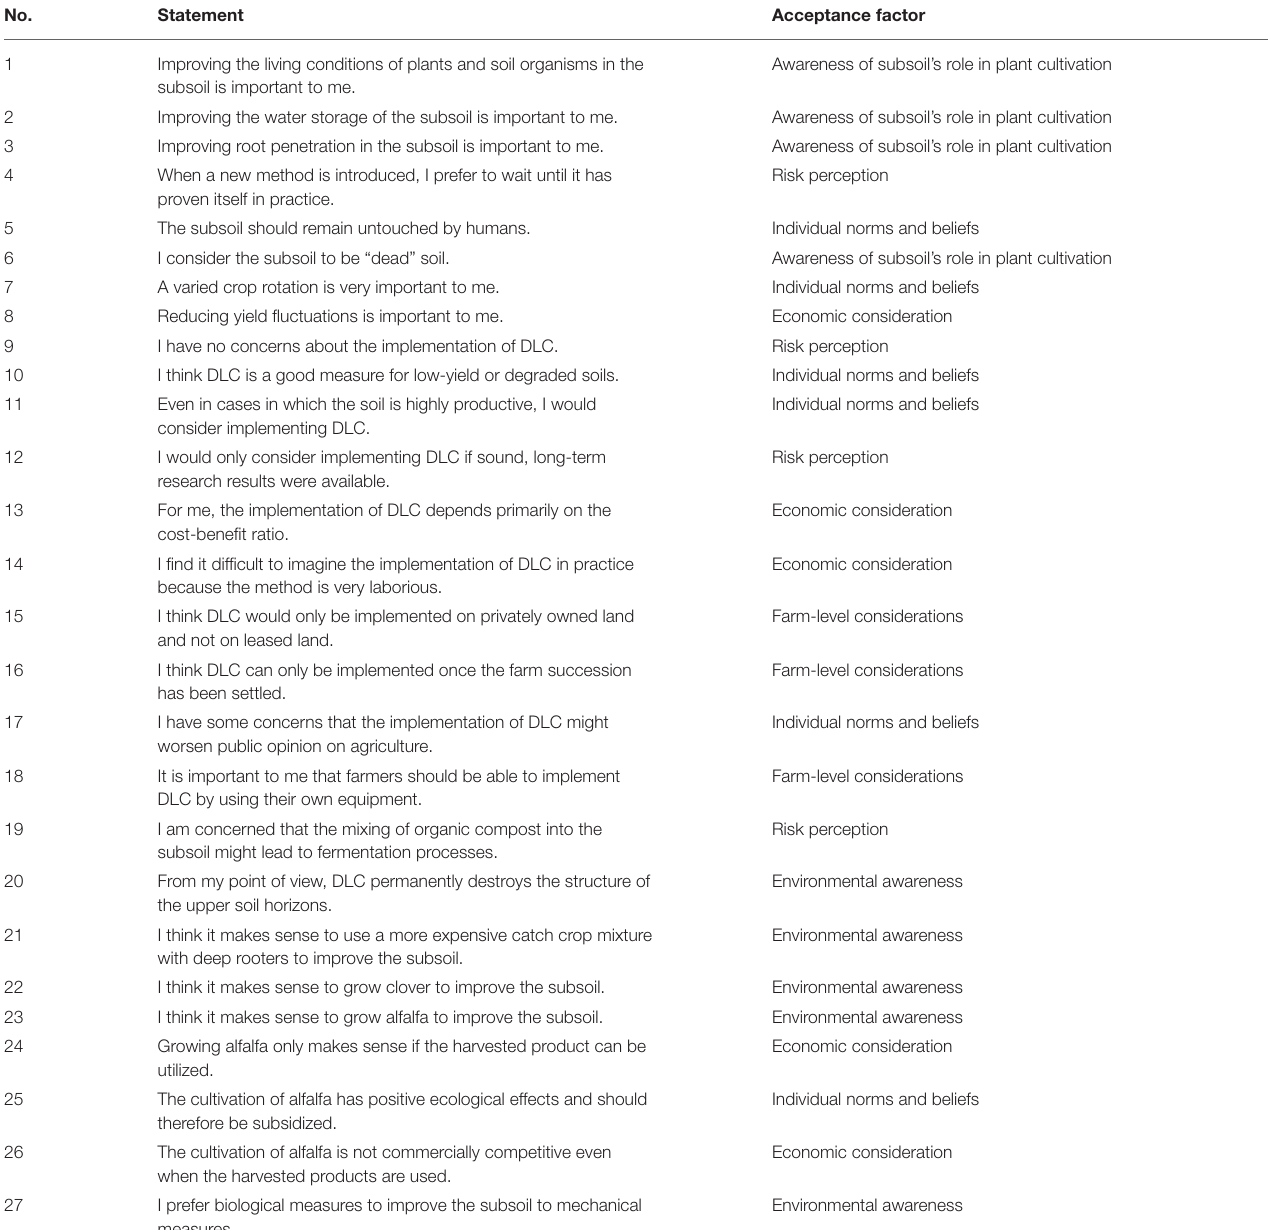
TABLE 1 | Q-set and corresponding acceptance